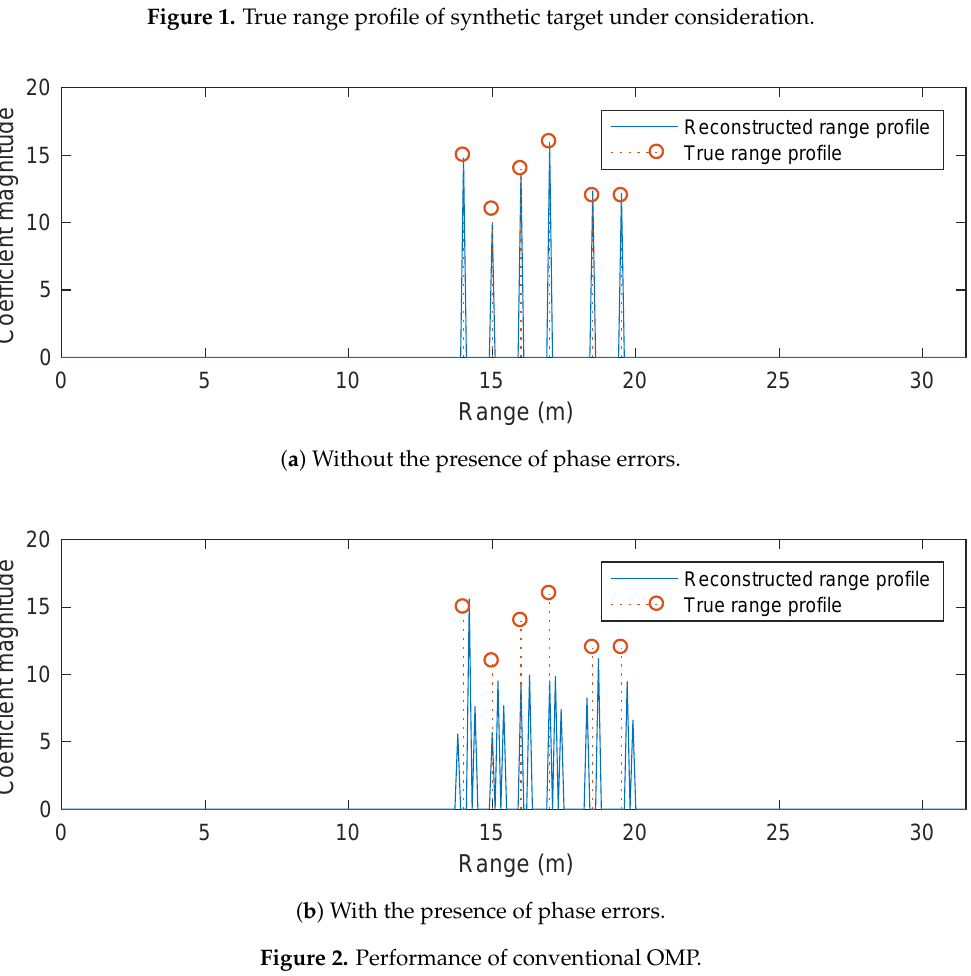
Figure 2. Performance of conventional